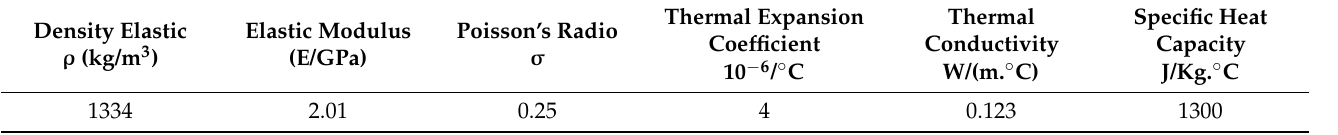
Table 1. Thermo-mechanical properties of Nomex paper